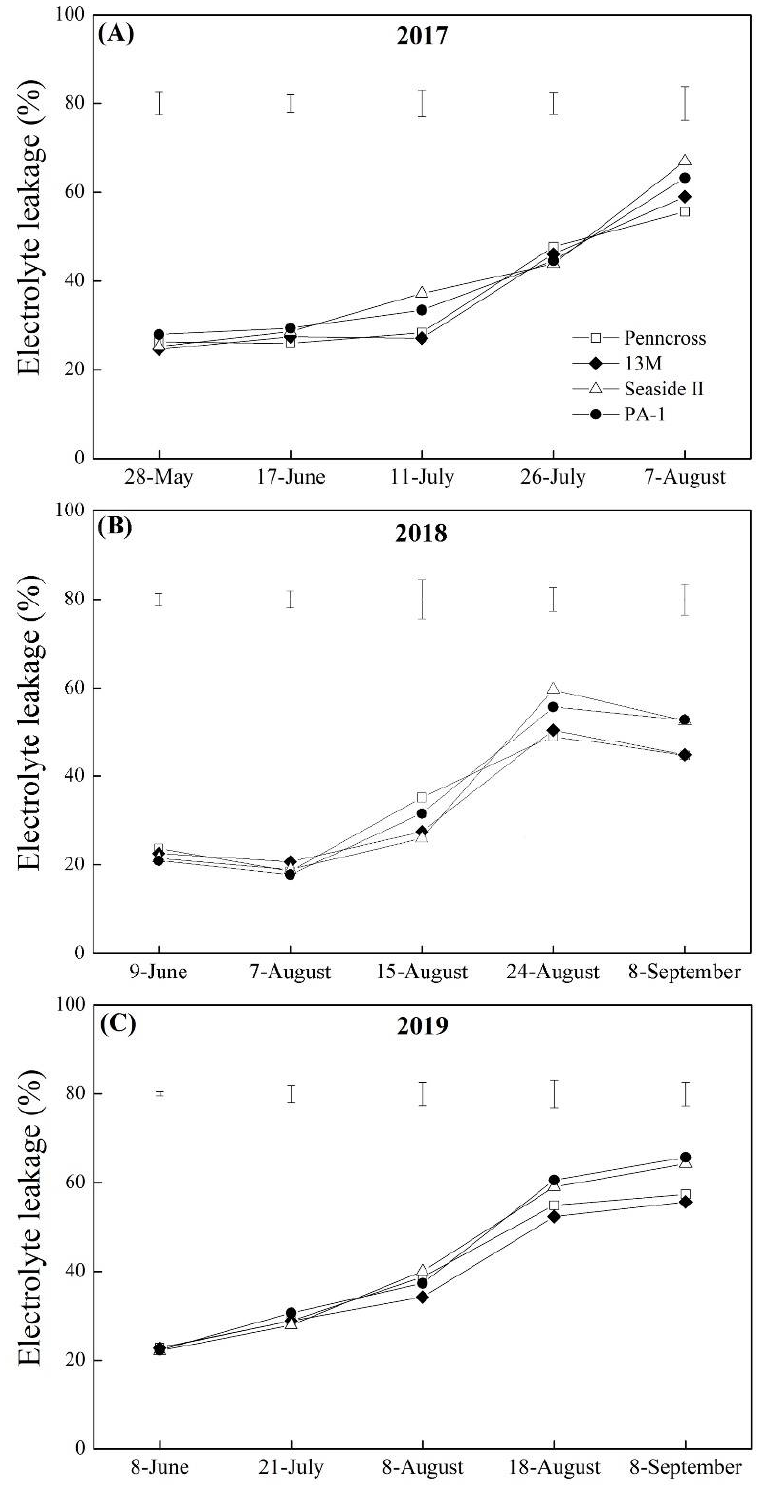
Figure 9. Change in electrolyte leakage (EL) of four different creeping bentgrass cultivars (Penncross, 13M, Seaside II, and PA-1) during summer in ( A ) 2017, ( B ) 2018, and ( C ) 2019. Vertical bars above curves indicate least significant difference (LSD) values ( p < 0.05) at a given day.